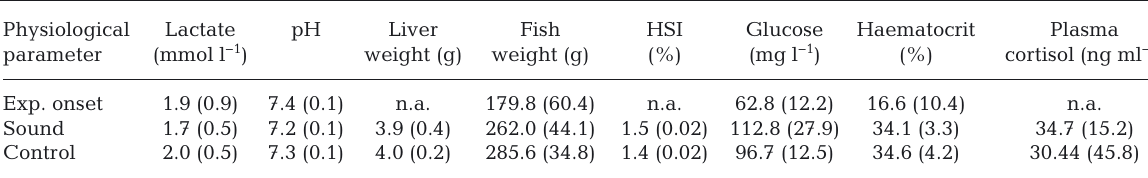
Table 1. Mean (±1 SE) Atlantic salmon blood and histological parameters as measure at experimental onset and at experimen- tal completion at 8 wk in sound treatment (exposure to 127 dB re 1 µPa) and control (exposure to <90 dB re 1 µPa). HSI: hepato- somatic index; n.a. indicates value not available (at experimental onset). N = 9 in all cases except lactate (N = 8 for both control and sound